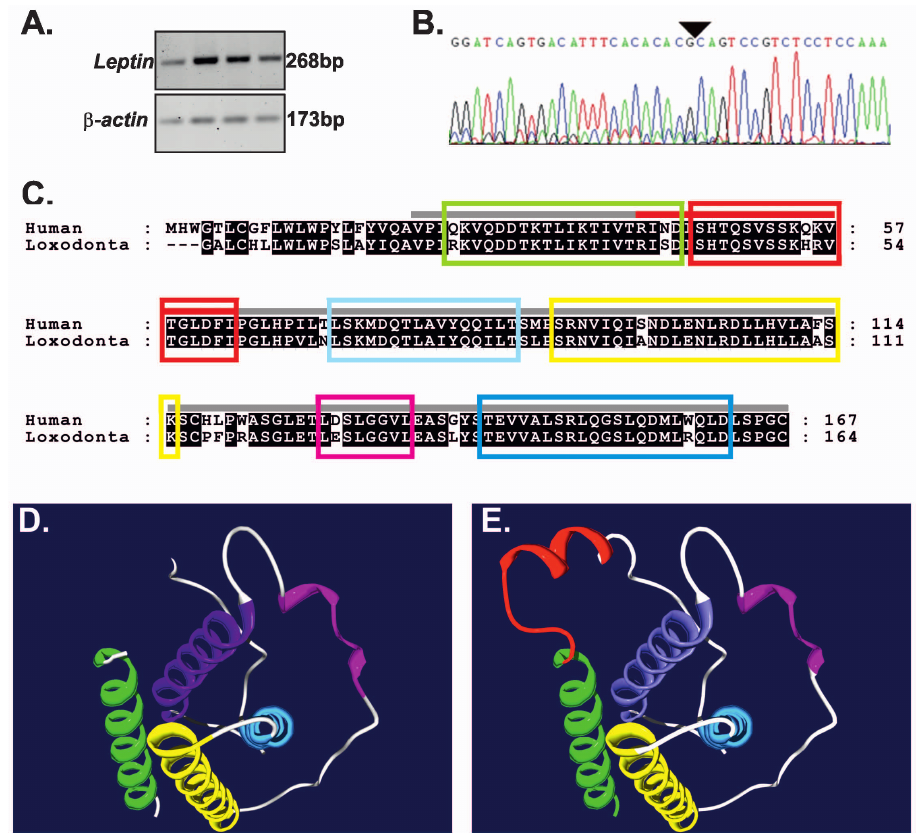
Figure 3. Leptin expression in African elephant visceral fat and comparison of African elephant leptin with the sequence and structure of human leptin. RT-PCR confirms expression of leptin in elephant visceral fat (A) and identified an exon-exon boundary (B), derived amino acid sequence (C), structure of human leptin (1AX8) (D) and molecular model of elephant leptin (E). Residues conserved in all human and elephant leptin amino acid sequences are displayed as white text on black. Helices are color coded (C, D,E).